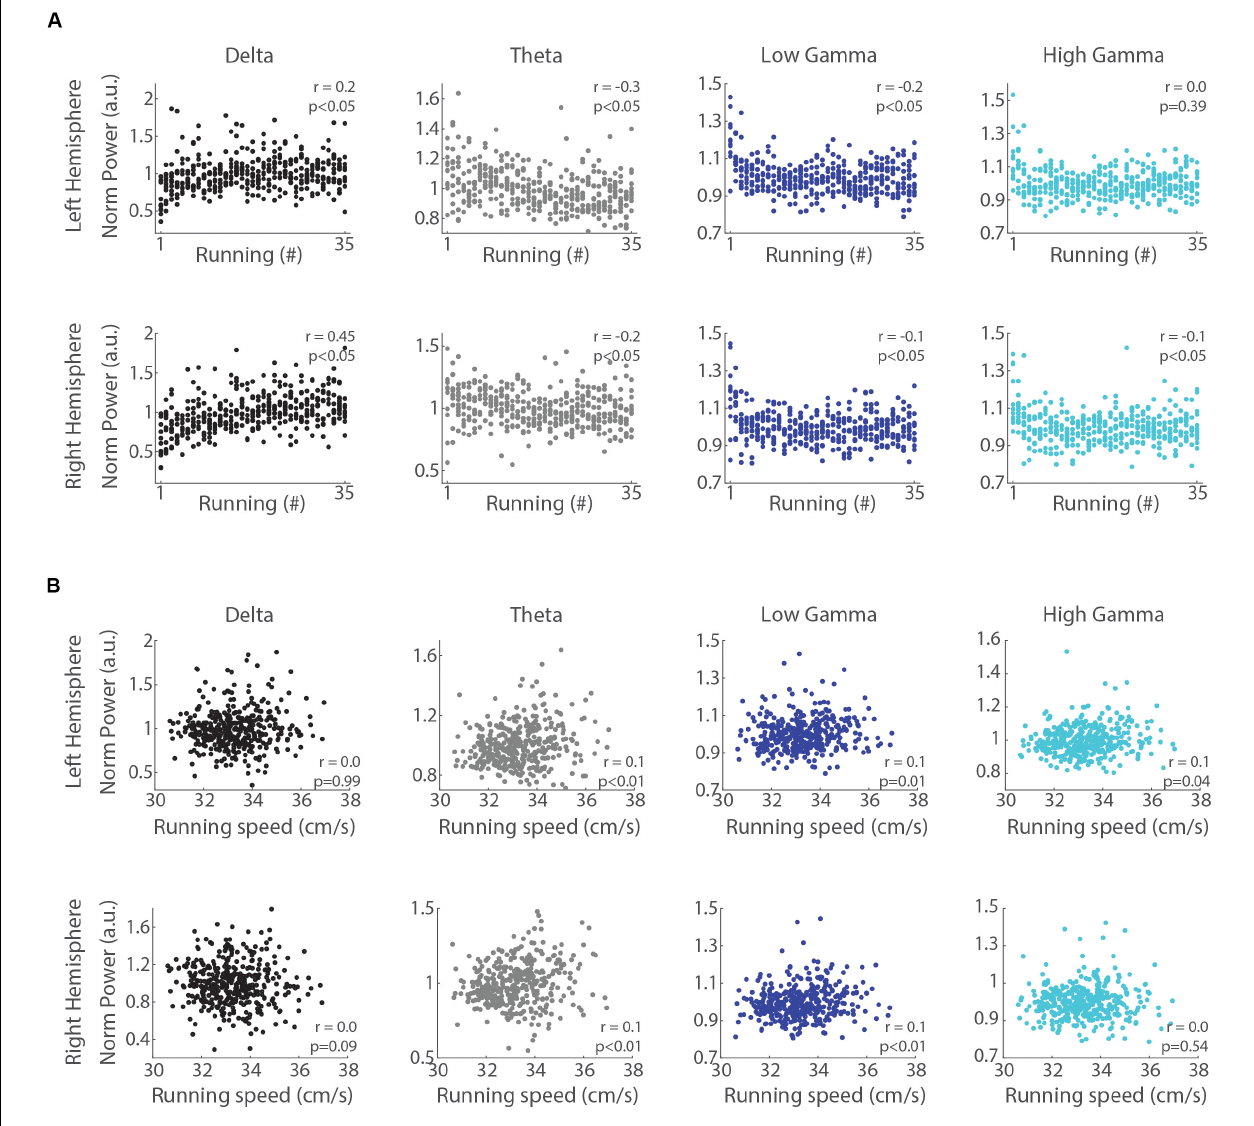
FIGURE 4 | Delta power correlates with the trial number but not with running speed. (A) Normalized delta band power during treadmill running and the trial number (“running #”) directly correlated ( r = 0.2, p < 0.05 and r = 0.45, p < 0.05, for left and right hemispheres, Spearman’s correlation), while the power of theta, low gamma and high gamma bands inversely correlated with the trial number ( p < 0.05, Spearman’s correlation), except high gamma power in the left hemisphere ( p = 0.39). (B) Normalized delta band power and running speed were not correlated ( p = 0.99 and p = 0.09 for left and right hemispheres, respectively, Pearson’s correlation), while the power of theta, low gamma and high gamma bands weakly and positively correlated with running speed ( p < 0.05, Pearson’s correlation), except high gamma power in the right hemisphere ( p =